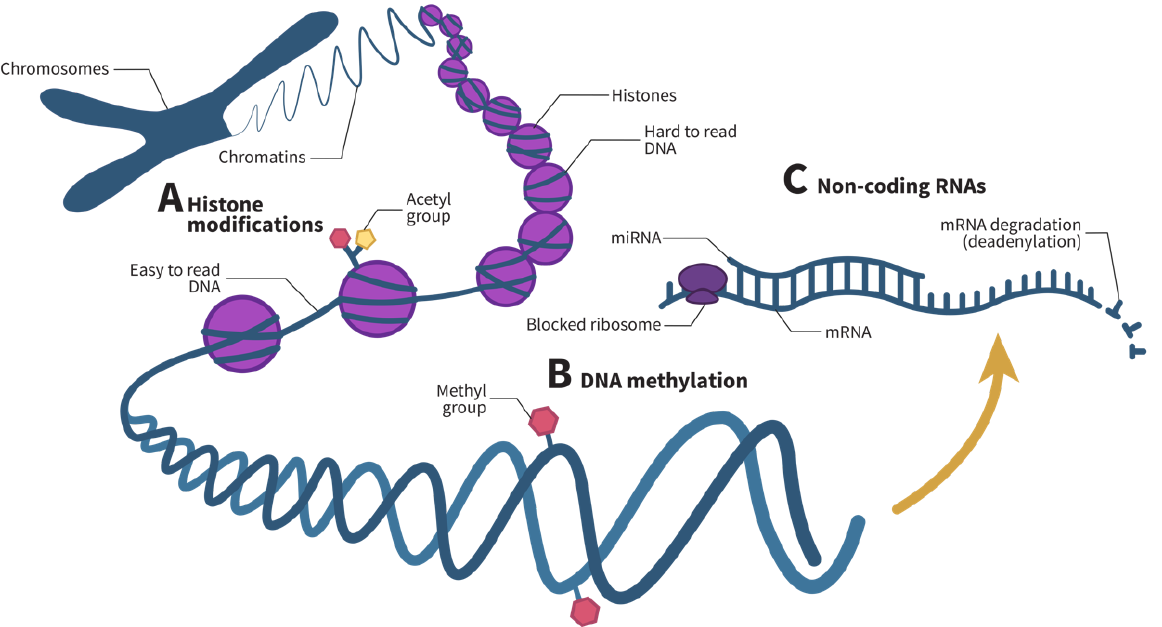
Figure 2. Epigenetic mechanisms act at various levels in gene expression. ( A ) Histone modifications, often including histone acetylation or methylation, untangle histones, render certain genes easier to read. ( B ) DNA methylation, on the other hand, represses gene transcription. ( C ) Finally, noncoding RNAs regulate gene expression post-transcriptionally. Specifically, microRNAs (miRNAs), one of the main noncoding RNAs that regulate gene expression, prevent messenger RNA (mRNA) translation by blocking ribosomes and speeding up mRNA degradation by deadenylation. Adapted from Chang et al. and Zhang et al. [42,43].